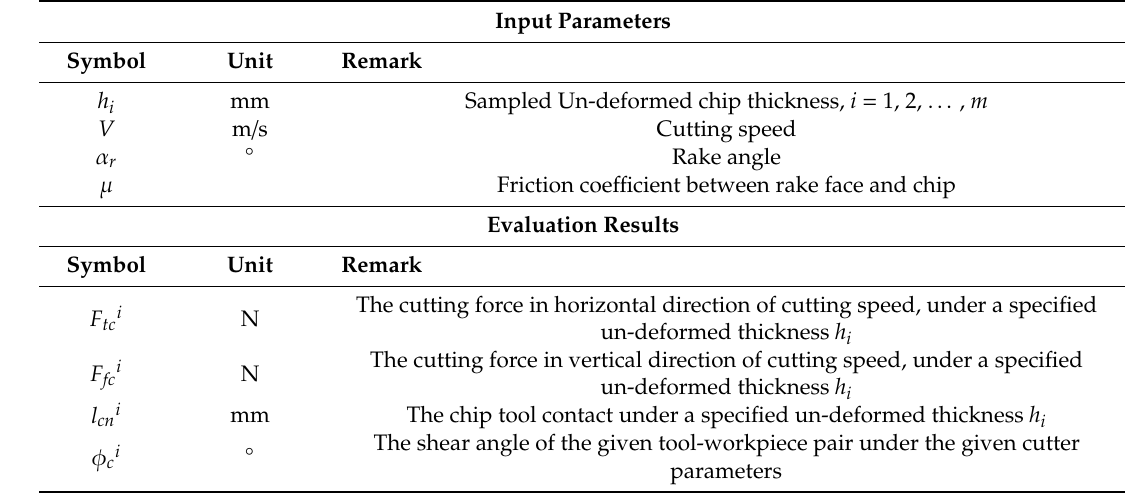
Table 1. The input parameters and evaluation